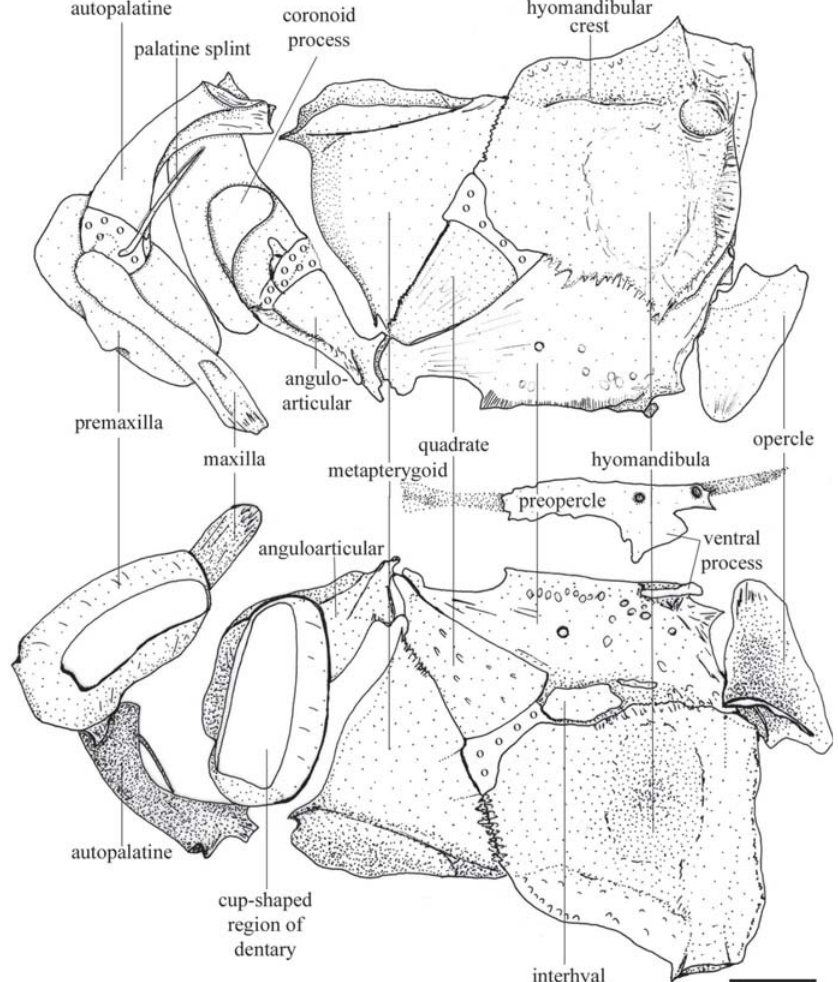
Fig. 29. Dorsal view (upper) and ventral view (lower) of left madibular arch, suspensorium, opercle, and interhyal of Lamontichthys stibaros (FMNH 84111, 62.4 mm SL). Lateral view of preopercle (centre). Scale bar = 1